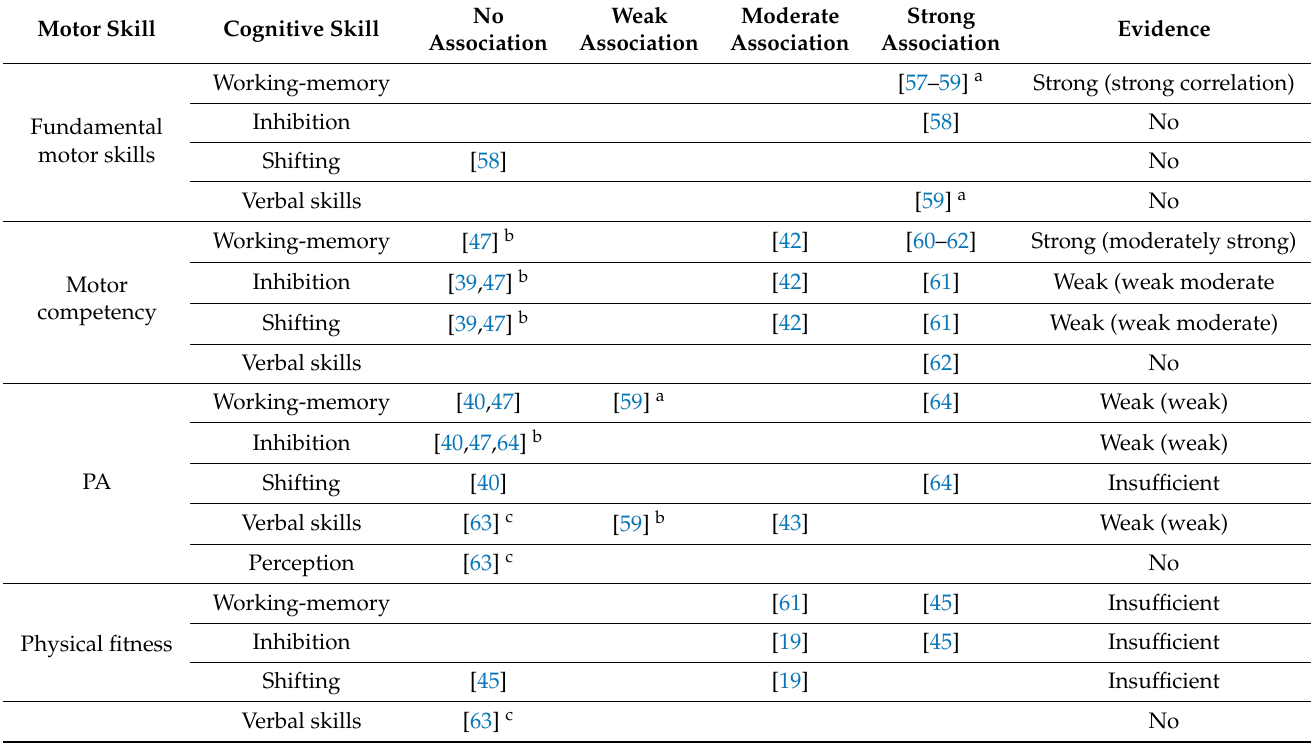
Table 3. Summary of systematic review of the relationships between motor skills and executive